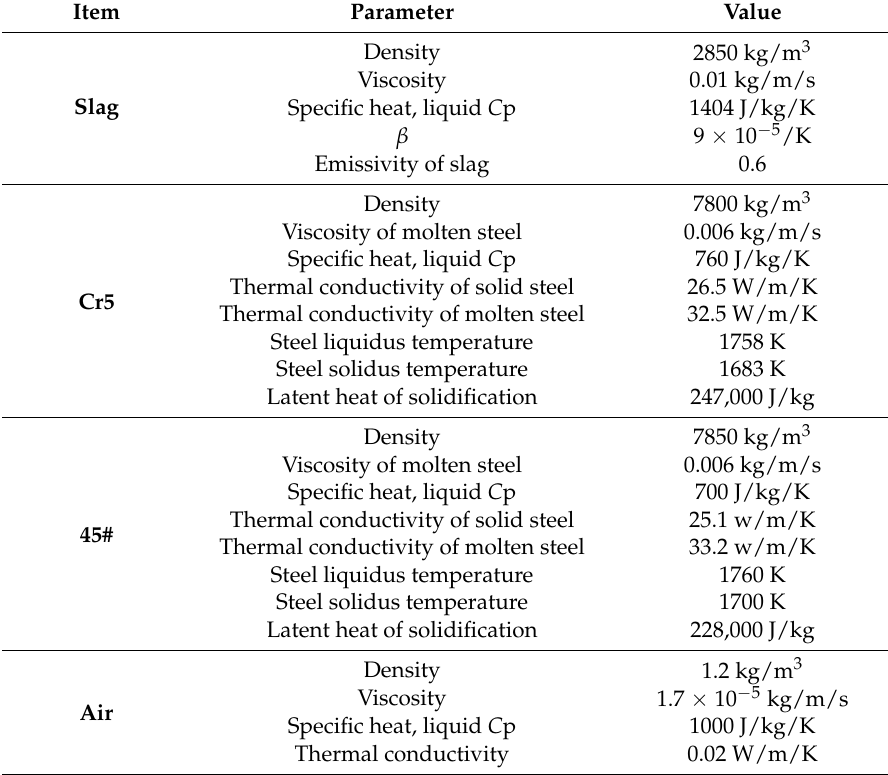
Table 2. Physical parameters of slag/steel/air.